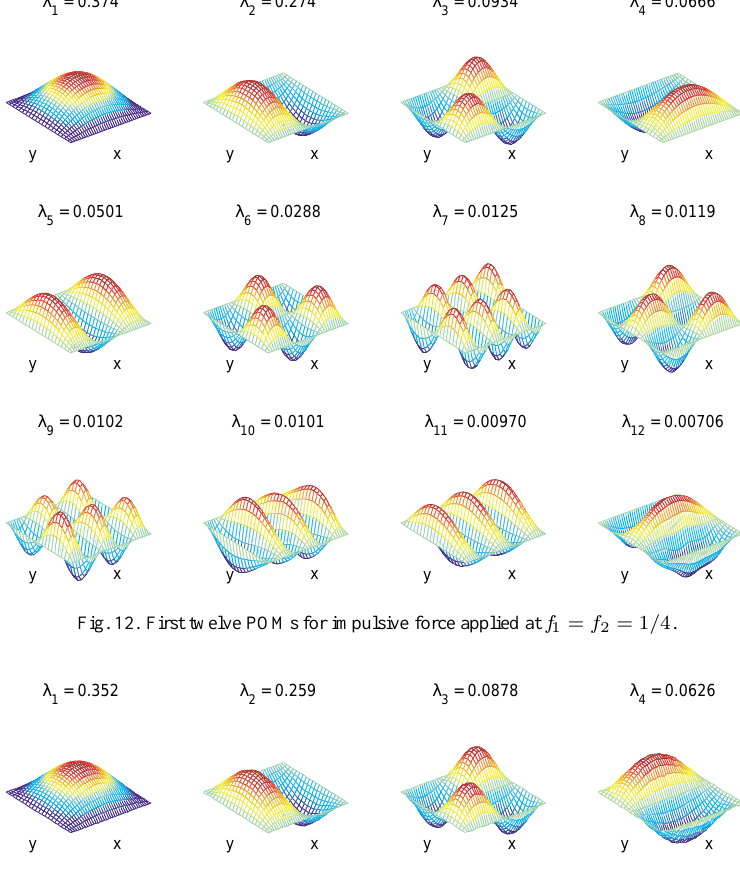
Fig. 12. First twelve POMs for impulsive force applied at f 1 = f 2 = 1 / 4 .